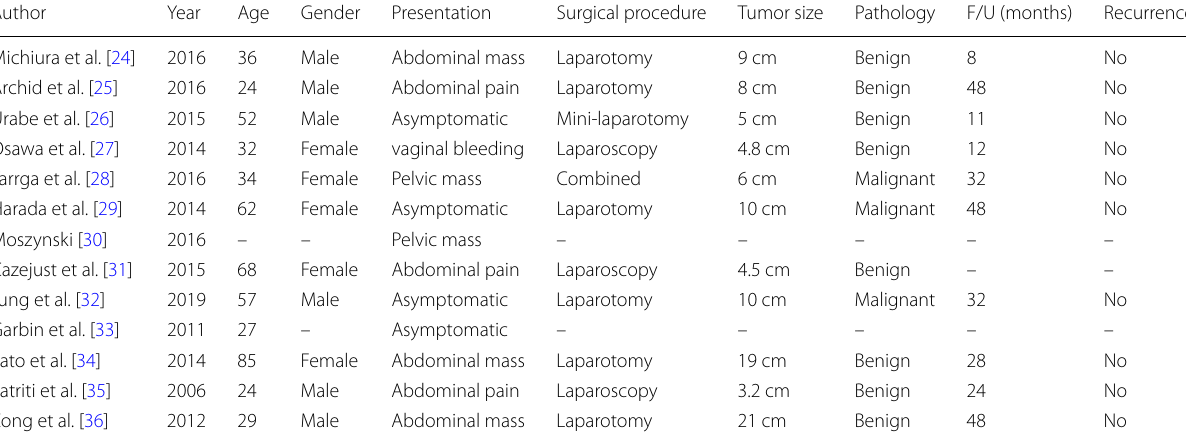
Table 1 Reported cases of greater omentum SFT in the